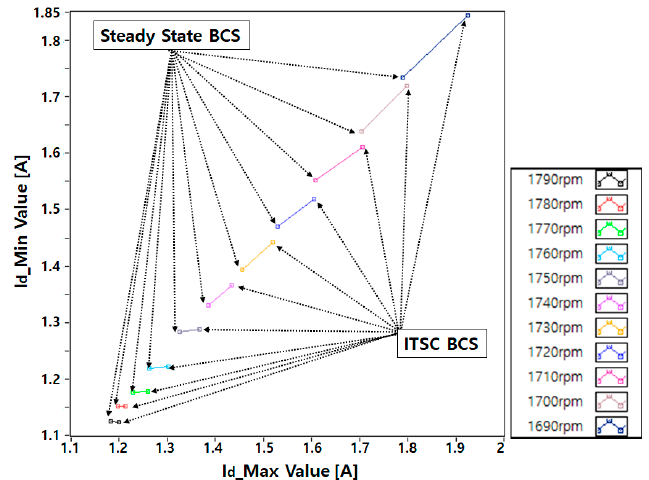
Figure 16. Between-class scatter (BCS) in the steady-state and the ITSC state according to speed change. To demonstrate the e ffi cient method at light load, eigenvector w = [ − 0.704105, 0.710096] for